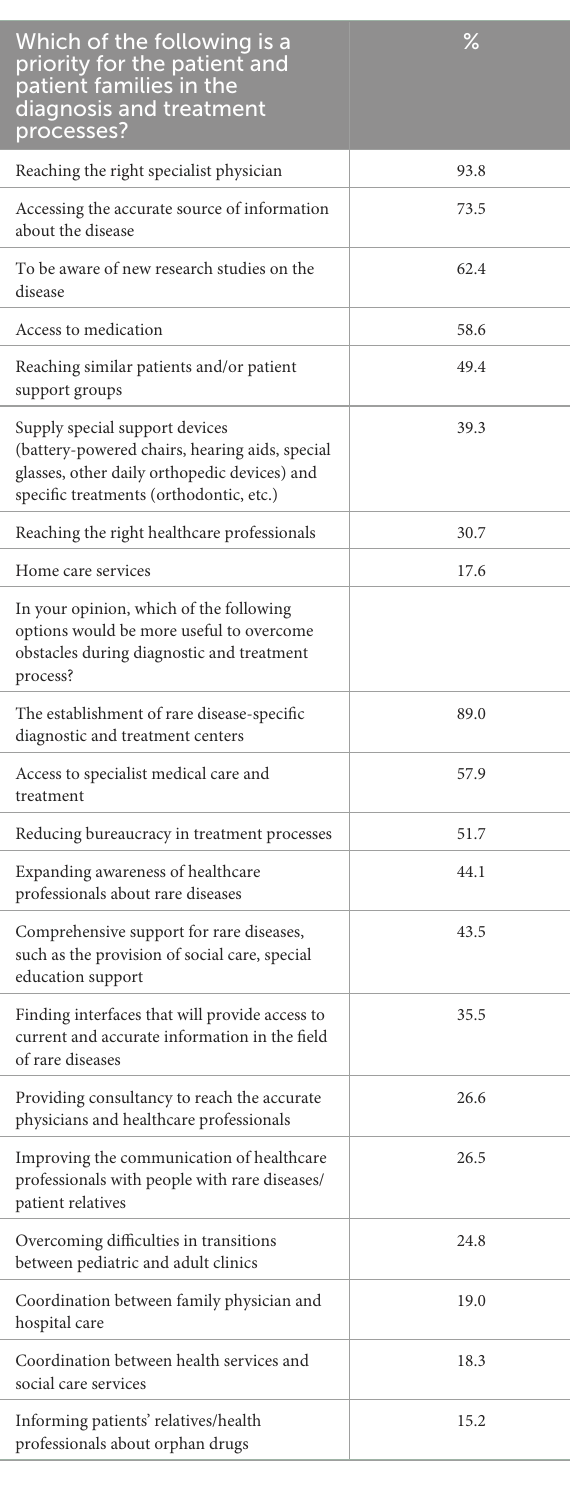
TABLE 7 Priorities for the patient and patient families in diagnosis and treatment